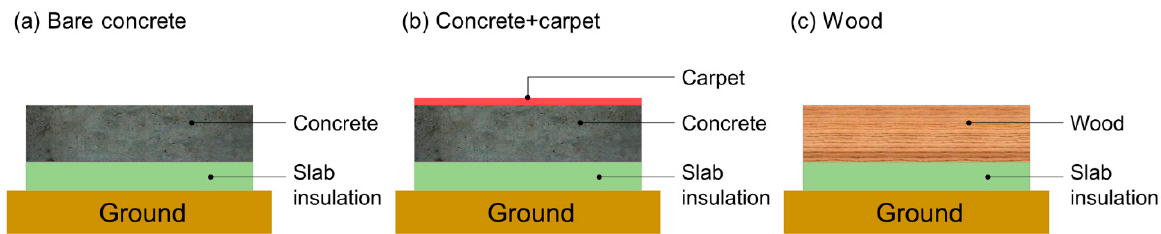
Figure 3. Cross-sectional views of the three examined floor configurations: ( a ) Bare concrete, ( b ) Concrete + carpet, and ( c ) Wood.